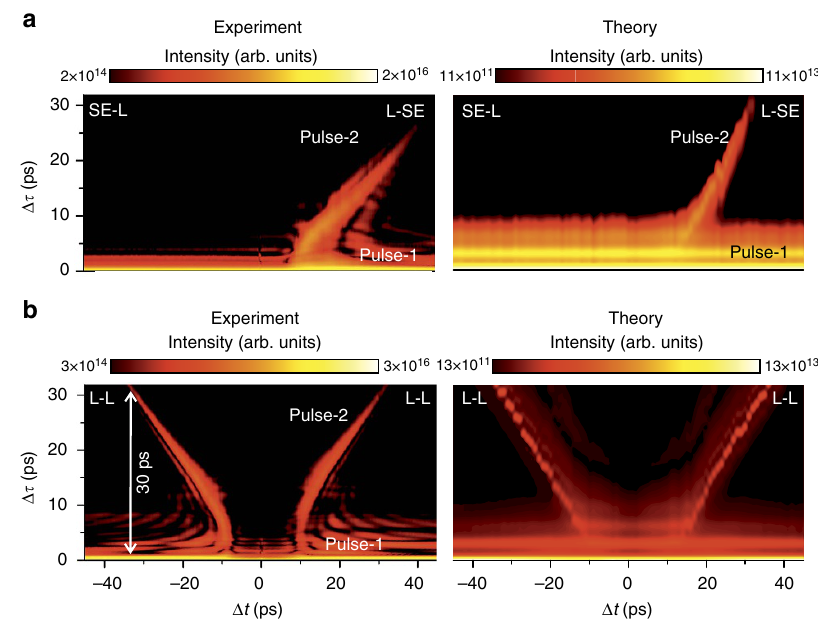
Figure 3 | Experimental and theoretical pump–probe data in the time domain. Time-dependent emission of the NW laser as a function of D t after Fourier transforming the optical spectra. The data are plotted on a logarithmic colour scale that spans two orders of magnitude. ( a ) Pump pulse in the lasing regime and probe pulse in the spontaneous emission regime (pump pulse power P pump B 5 (cid:3) P th and probe pulse power P probe B 0.6 (cid:3) P th ). ( b ) Pump and probe pulse in the lasing regime (L-L)—( P pump B 5 (cid:3) P th and P probe B 4.7 (cid:3) P th ).